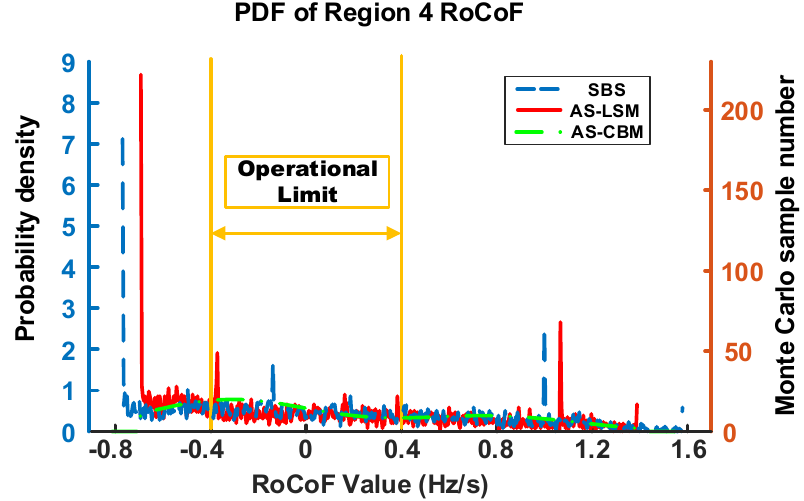
Figure 7. PDF of Region 4 RoCoF by SBS, AS-LSM, and AS-CBM. Table 5. Probabilistic distribution of the system, region 4, and region 5 RoCoF using SBS, AS-LSM, and AS-CBM within operational limits (correlated wind speed).